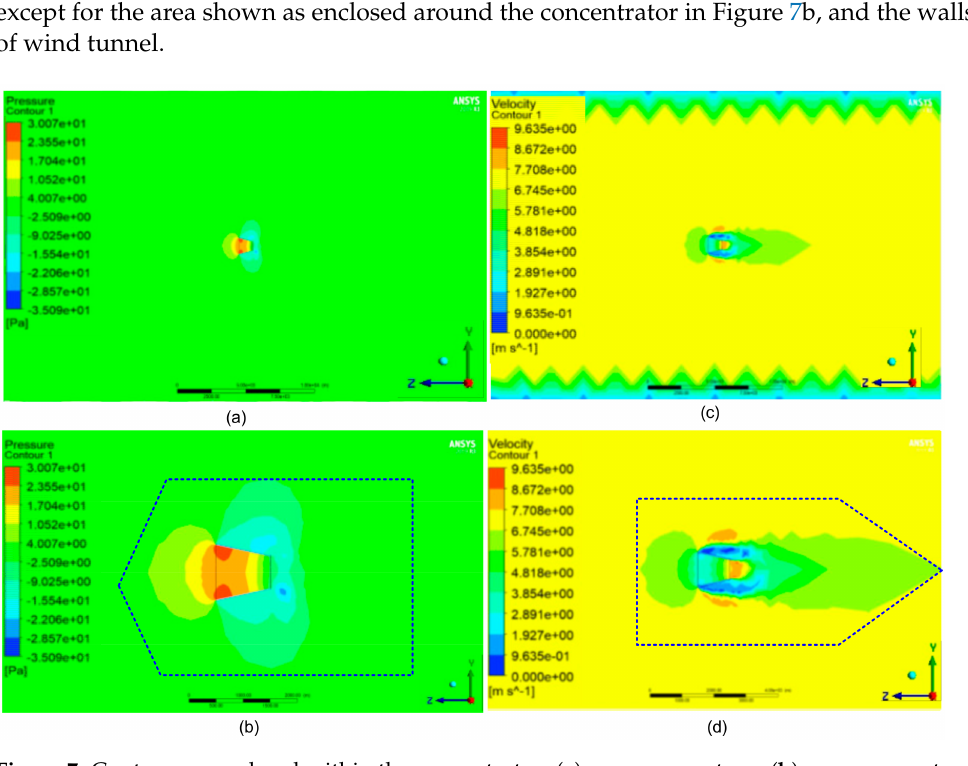
Figure 7. Contour around and within the concentrator: ( a ) pressure contour; ( b ) pressure contour (enlarged view); ( c ) velocity contour; ( d ) velocity contour (enlarged